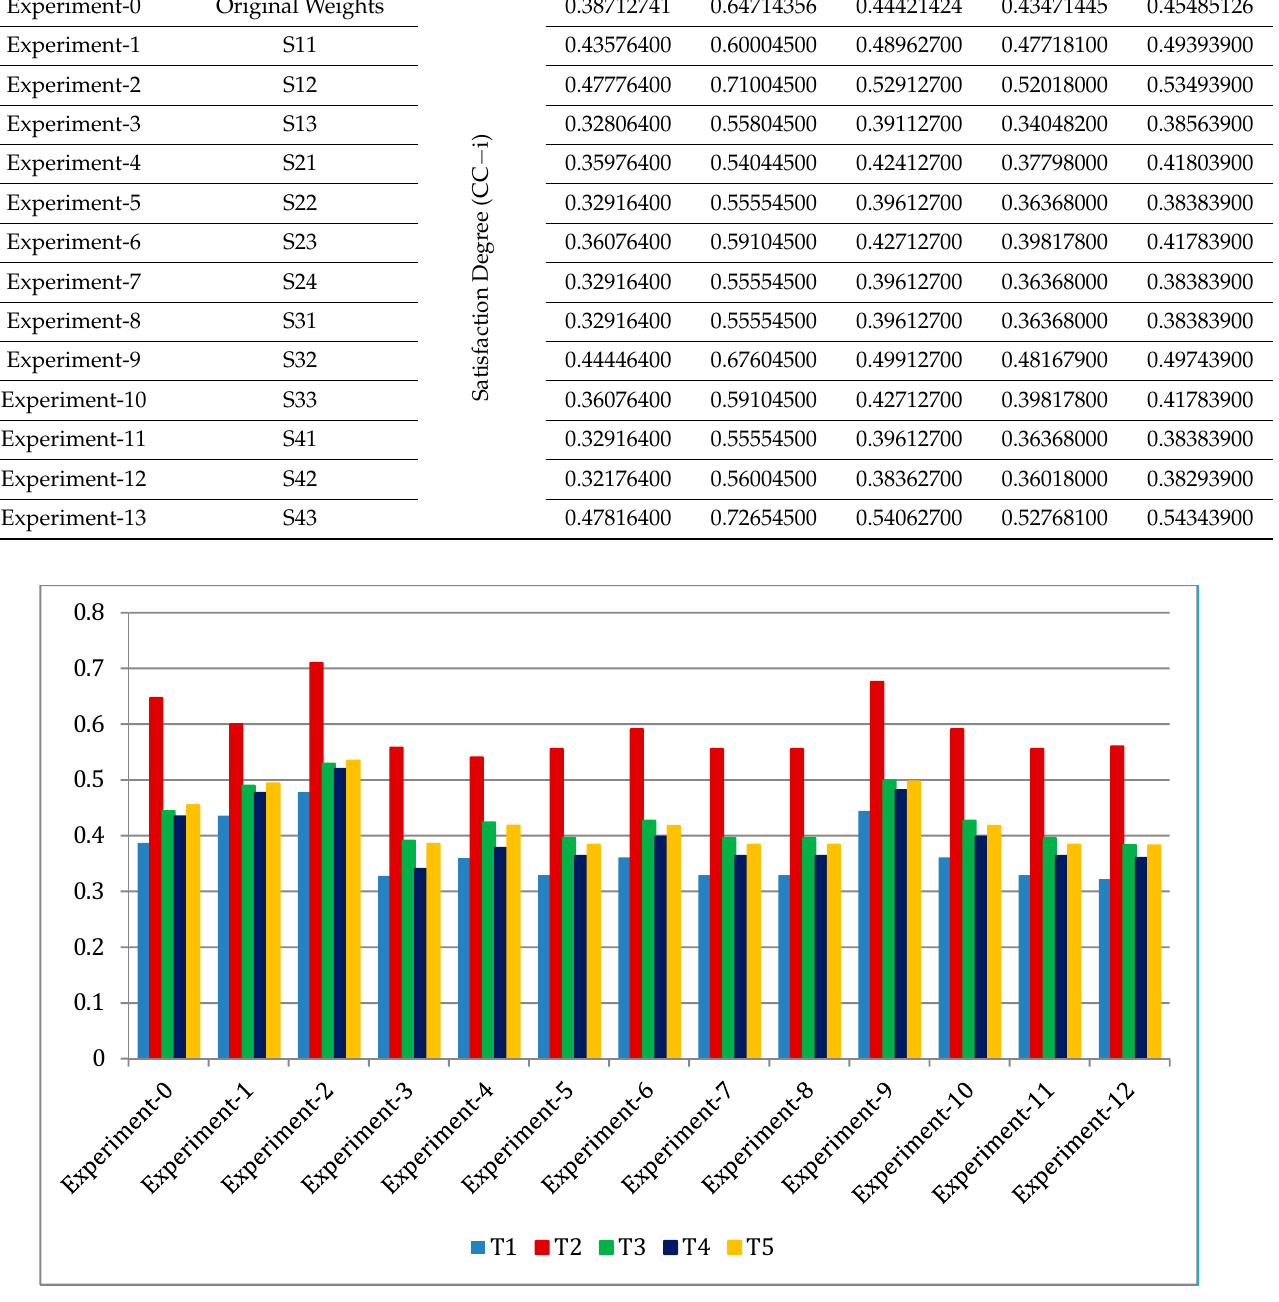
Figure 12. A graphical representation of the sensitivity analysis.